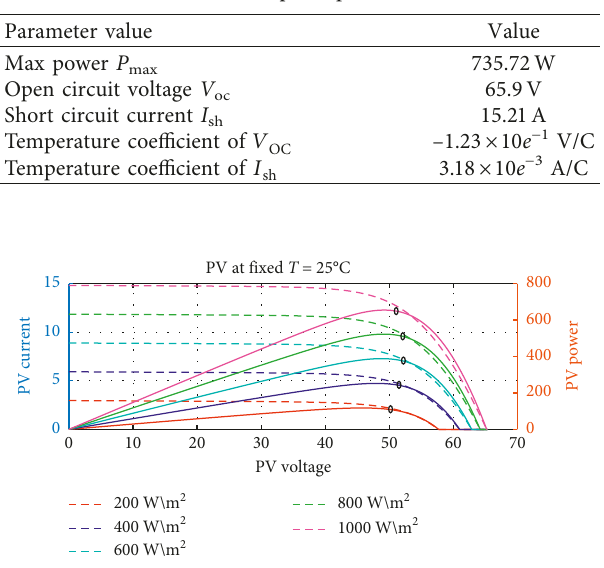
Table 1: PV panel parameters.